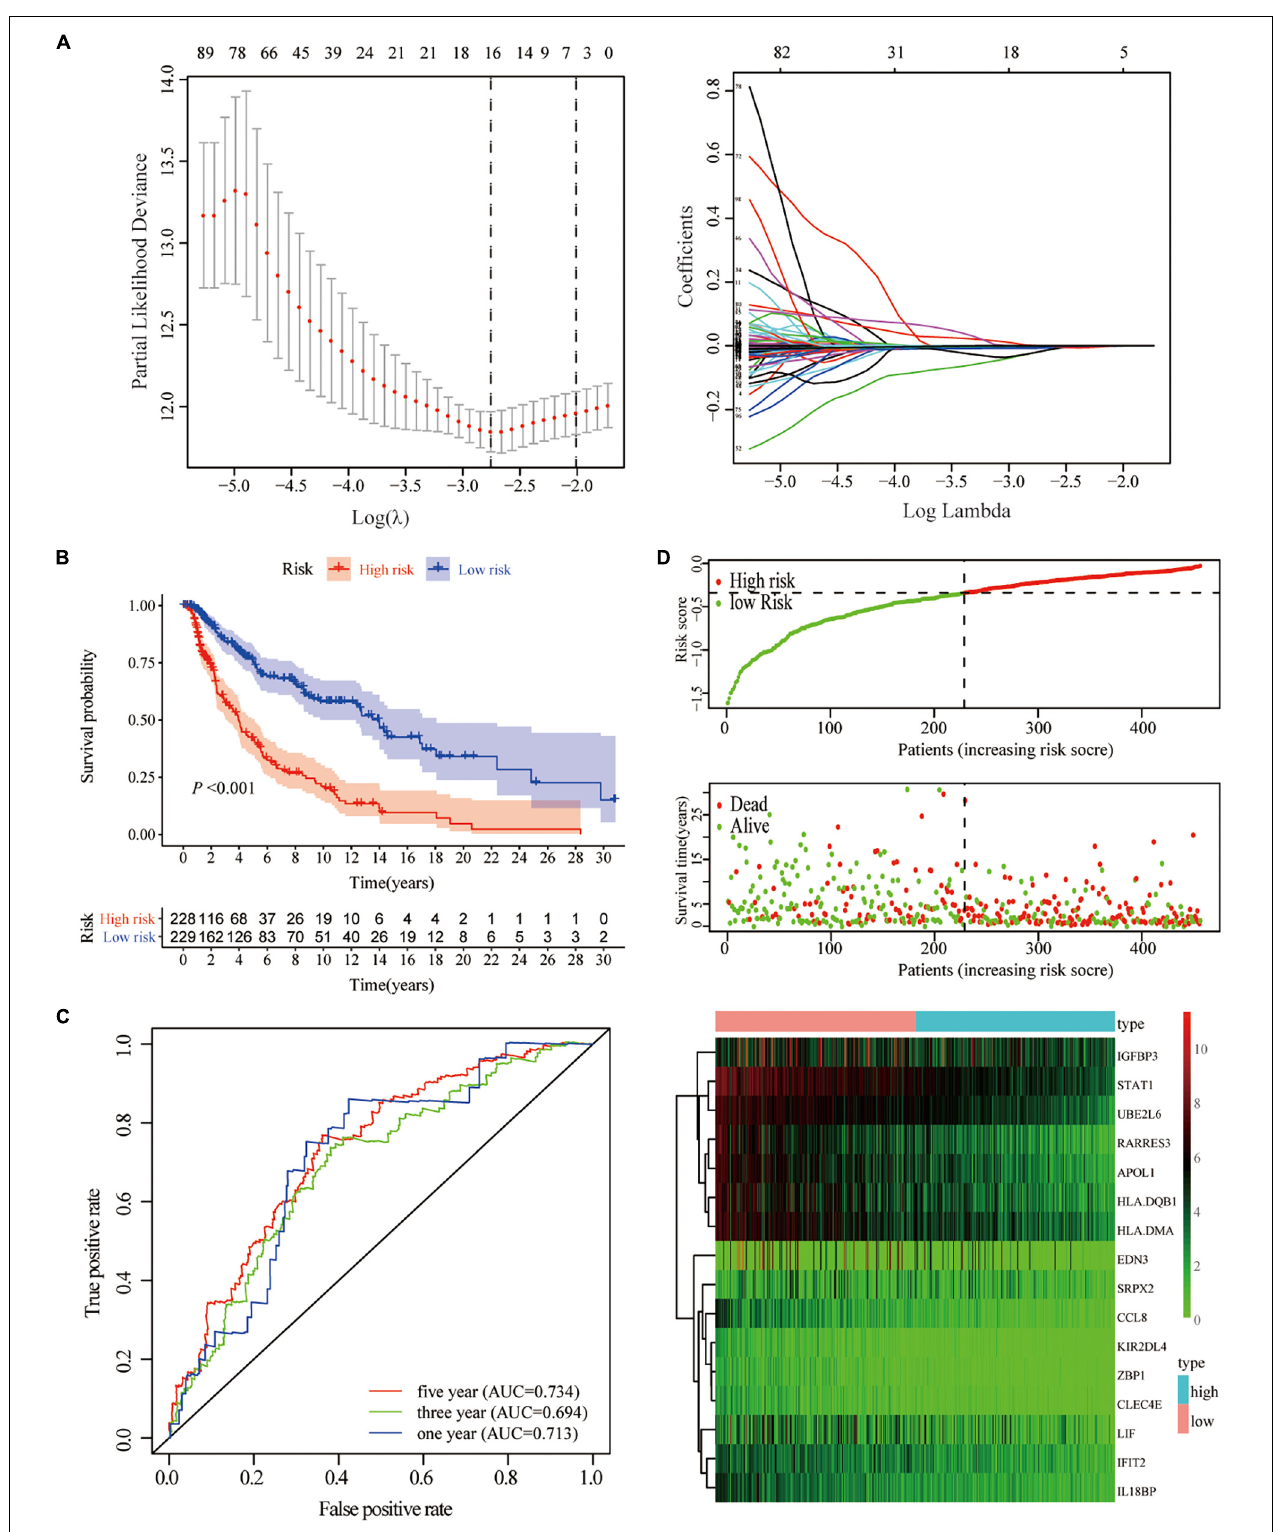
FIGURE 5 | Construction of gene-based risk prediction model. (A) LASSO Cox regression analysis identified 13 hub genes closely related to OS of TCGA-SKCM. (B) Kaplan–Meier plots assessed the impact of risk scores on the OS of SKCM patients in TCGA. (C) Time-dependent ROC curve analysis of the risk score. (D) The distribution of risk scores, the expression values of the 13 hub genes, and the survival status of SKCM patients ranked according to the risk scores.